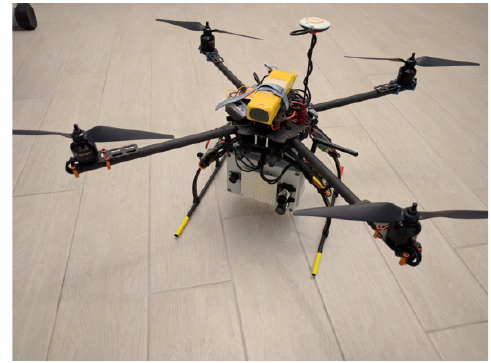
Figure 21 Experimental prototype mounted under a